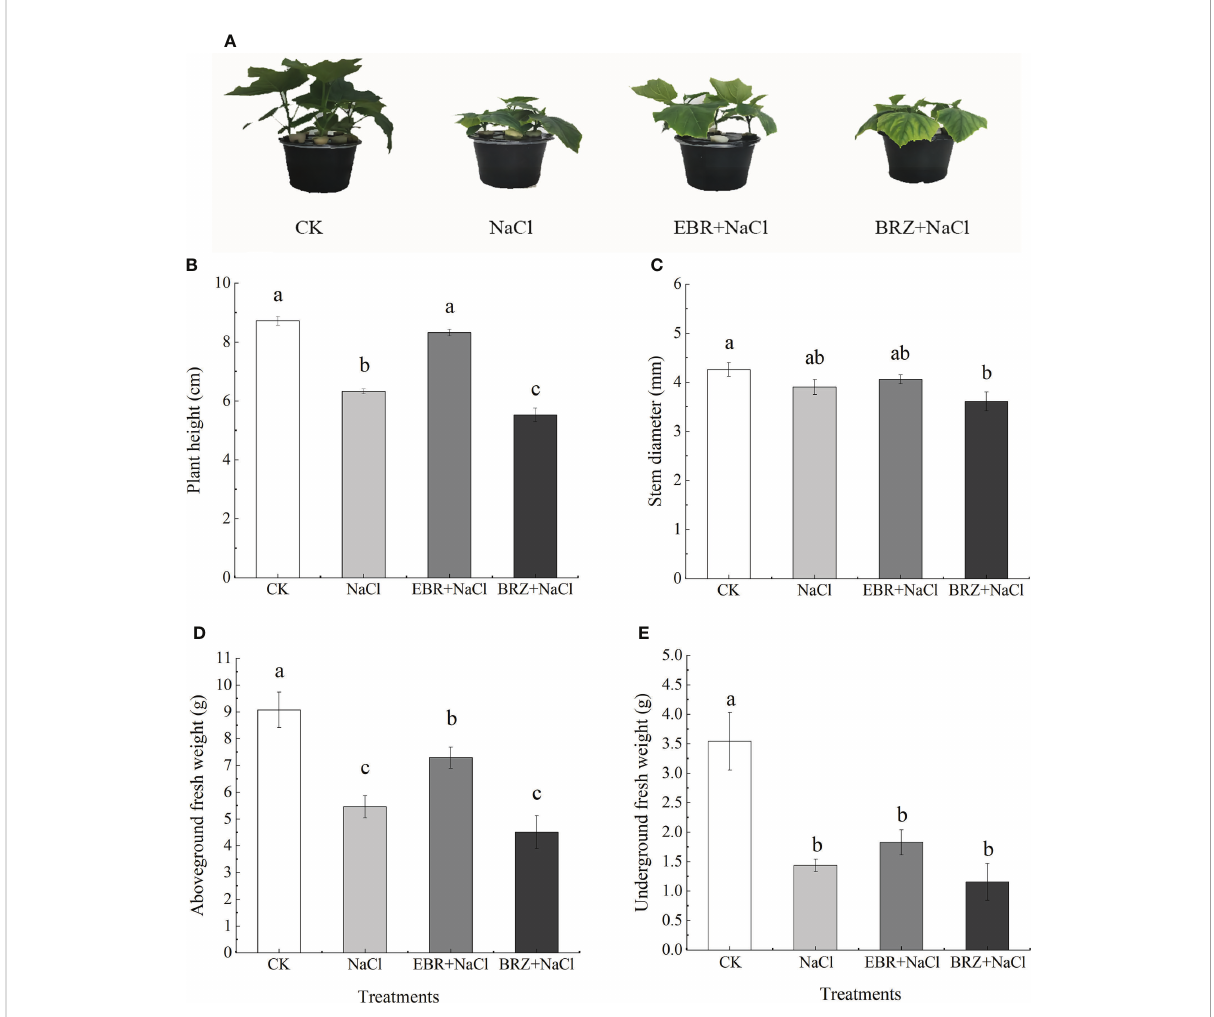
FIGURE 1 The effect of exogenous EBR on phenotype (A) , plant height (B) , stem diameter (C) , aboveground fresh weight (D) and underground fresh weight (E) of cucumber seedlings under salt stress. Set foliar spray with distilled water (CK) 50 mmol.L -1 NaCl (NaCl), 50 mmol.L -1 NaCl+foliar spray 0.02 m mol.L -1 EBR (EBR+NaCl), 50 mmol.L -1 NaCl + foliar spray The surface was sprayed with 24 m mol.L -1 BRZ (BRZ+NaCl). The treatment was conducted once every 24 h, and the related indexes were determined after 7 times consecutive treatments. Data are means ± SE of three replicates. Different letters indicate signi fi cant differences at P < 0.05 according to Dun ’ an ’ s multiple range